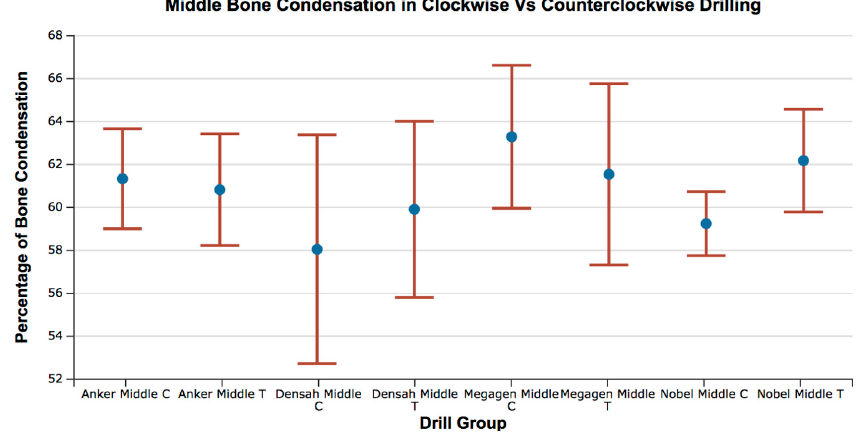
Figure 9. Box plot for the percentage of bone condensation at the middle area for all groups. C = clockwise drilling; T = counterclockwise drilling. Table 4. Descriptive statistics. Relative bone condensation at the middle region. Table 5. Statistical comparison of the relative bone condensation at the middle region for all groups. No significant differences were observed between groups. T = Test, C = Control, SE = Standard Error, t = test, p = p